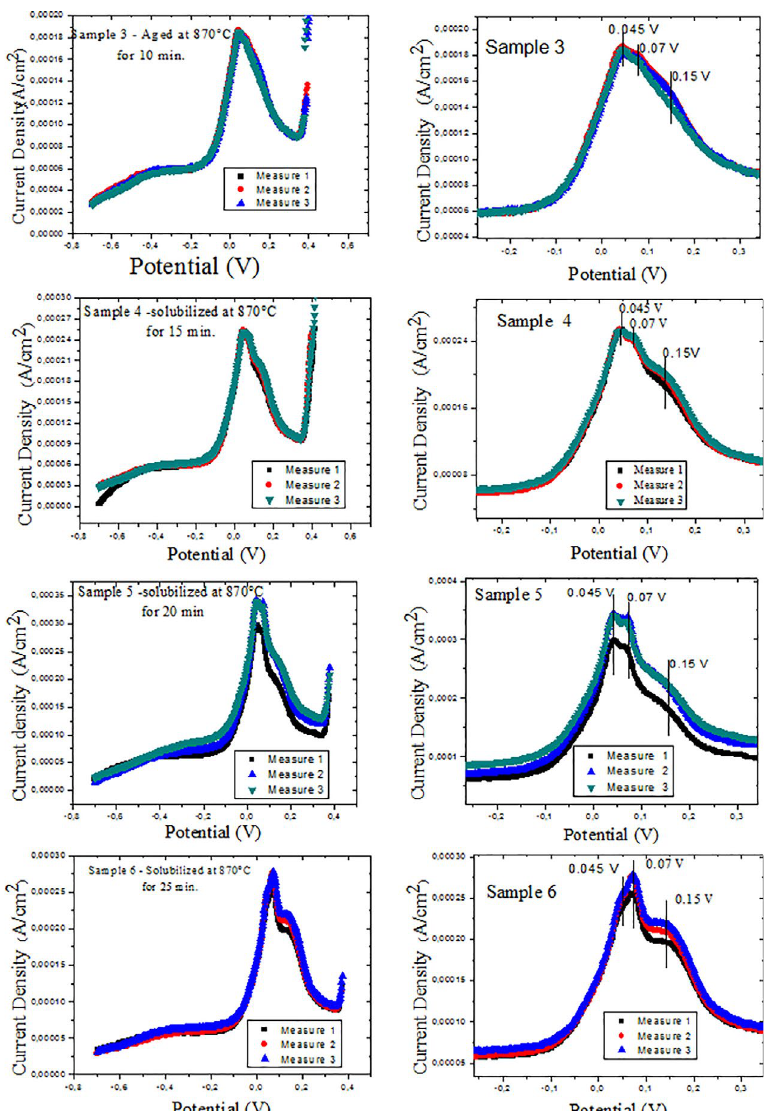
Figure 7. Linear Sweep Voltammetry of steel UNS S31803 for different heat treatment conditions in 3 mol /L KOH solution and 2 mV/s of scan rate. On the right is the zoom of the region where the current peaks occurred at 0.045, 0.07 and 0.15